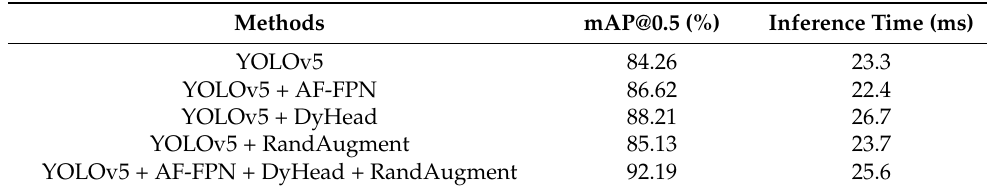
Table 2. Ablation study on our improvements. All of the following methods use Mixup and Mosaic by default.